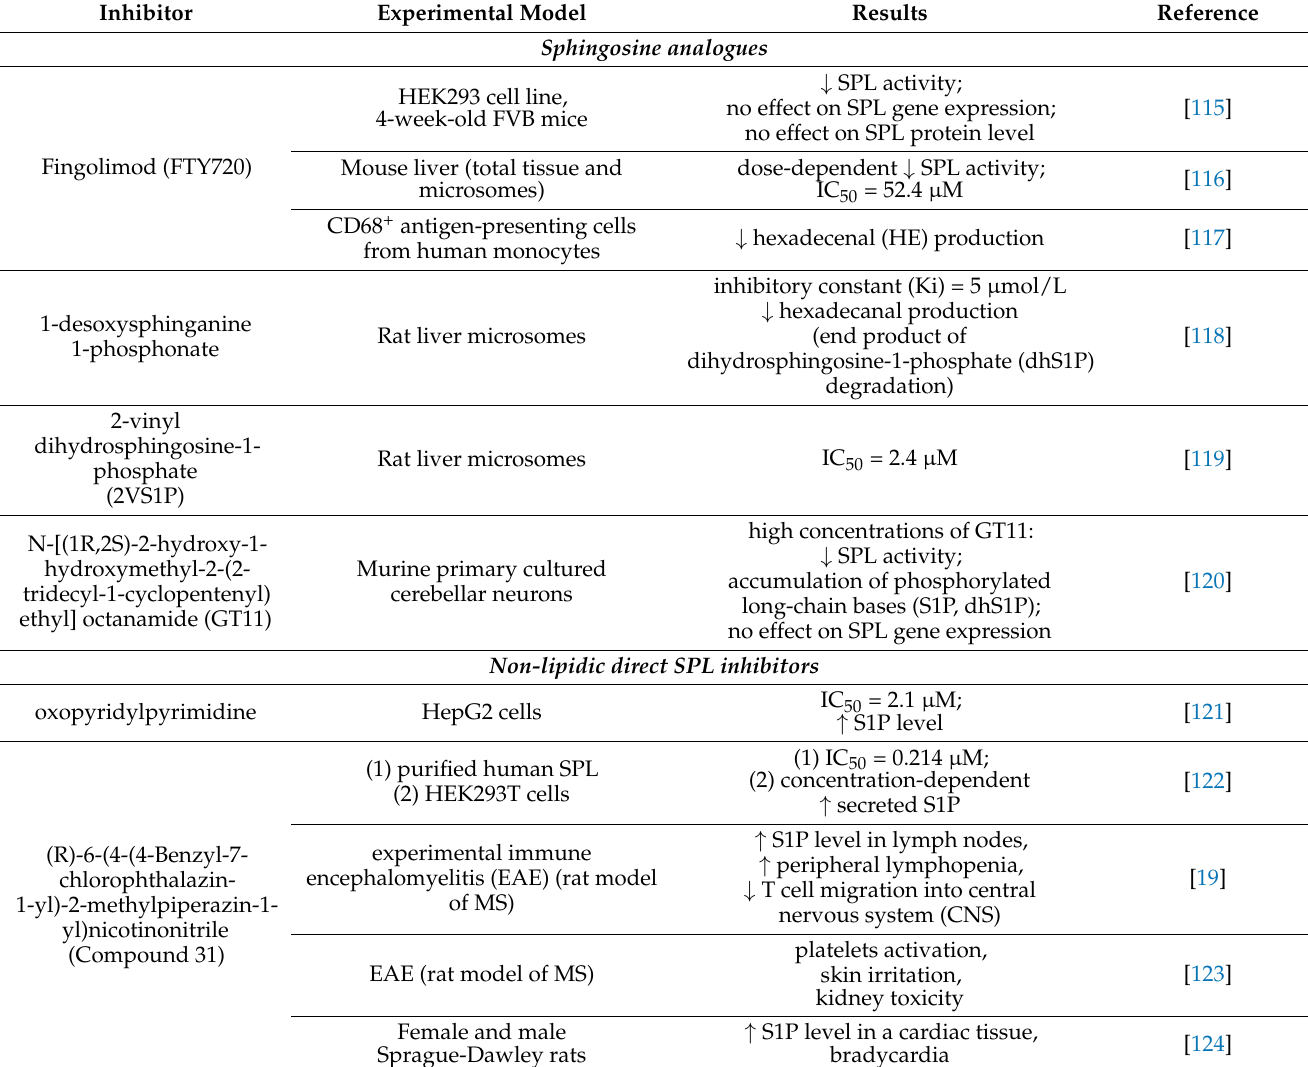
Table 1. The summary of the studies on SPL